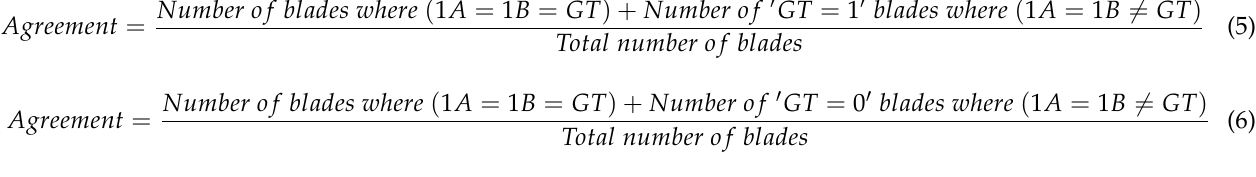
Table 2. Agreement acceptance limits for false positives (FP) and false negatives (FN) as per AS13100